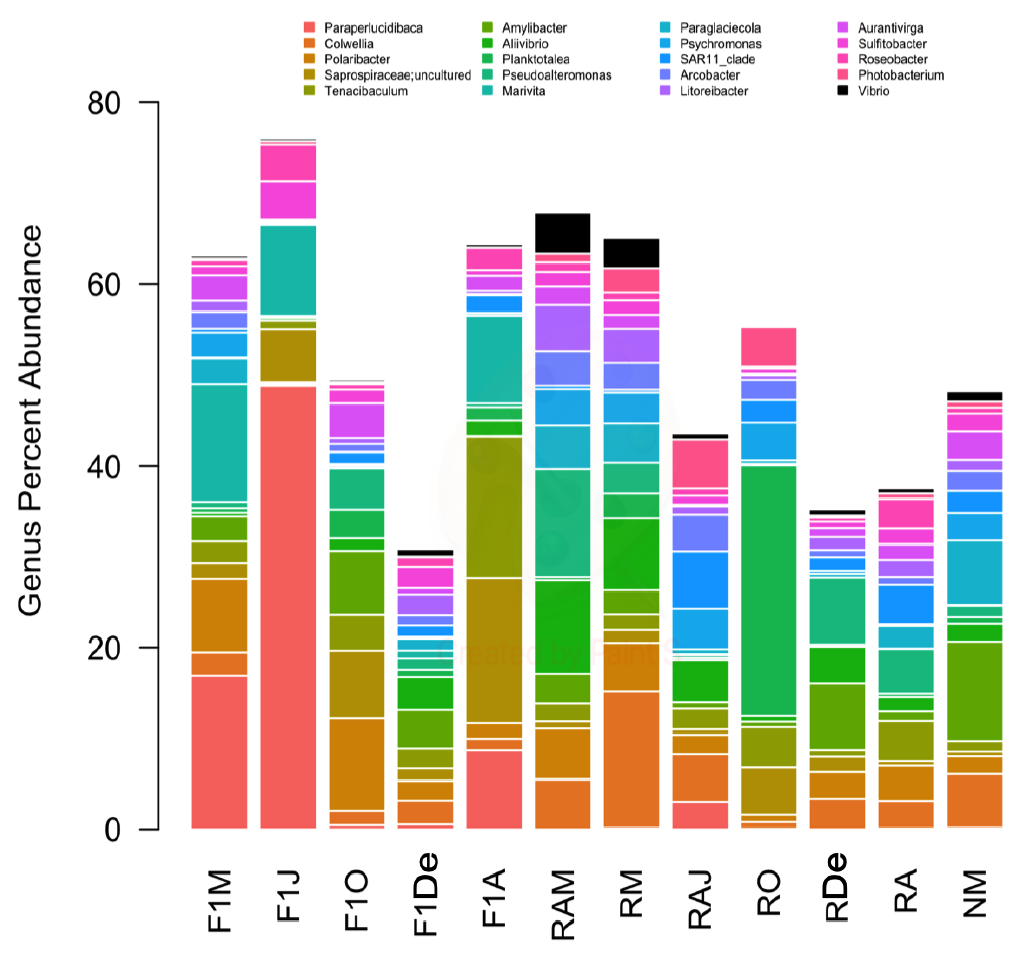
Figure 3. Composition of samples based on the 20 most abundant bacterial genera and the genus Vibrio , which was the twenty-seventh most abundant genus. Colors correspond to the genera given in the legend.; Vibrio is shown in black. F1M, F1J, F1O, F1De, and F1A: first-generation juvenile specimens born in the center (F1) sampled in March, June, October and December 2014, and April 2015, respectively. RM, RO, RDe, and RA: younger reproductive adults sampled in March, October, and December 2014 and April 2015, respectively. RAM, RAJ: older reproductive adults sampled in March and June 2014, respectively. NM: Nursery larvae sampled in March 2014.